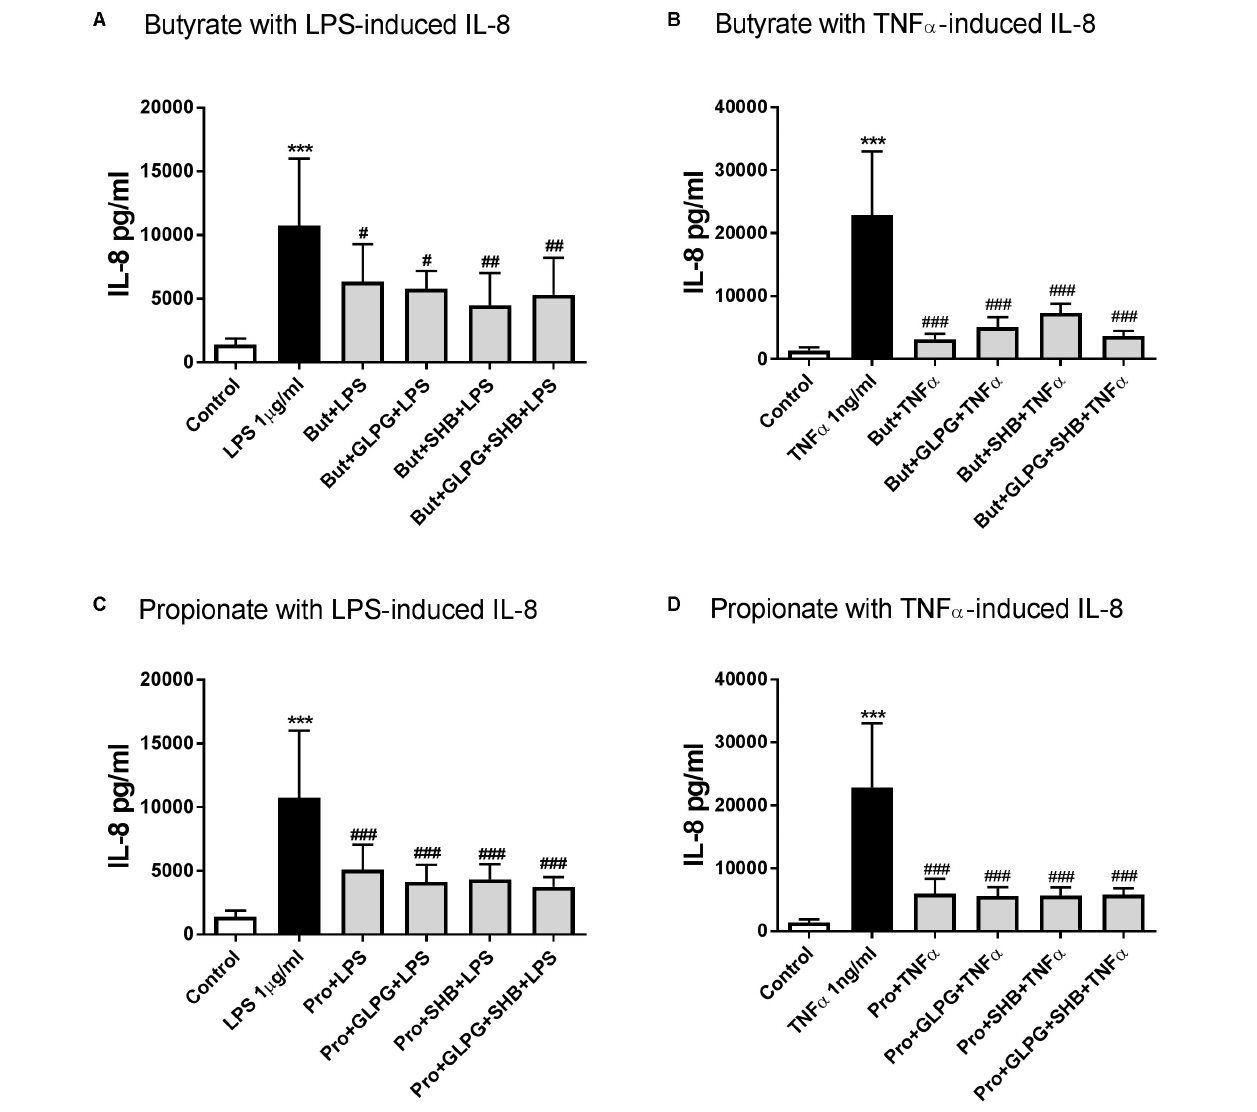
FIGURE 3 | Butyrate and propionate inhibited IL-8 production in LPS and TNF α -stimulated HUVEC. With 24 h pre-treatment, butyrate and propionate reduced IL-8 production in 24 h LPS or TNF α stimulation. (A) and (B) are the data of butyrate effects on LPS- and TNF α -induced IL-8 production, respectively; (C) and (D) are the data of propionate treatment. N = 4, ∗∗∗ p < 0.001 compared with control group; # p < 0.05, ## p < 0.01, ### p < 0.001 compared with LPS or TNF α